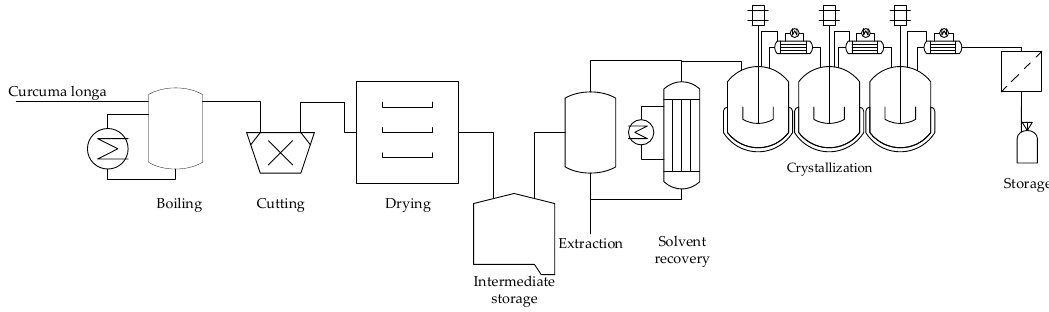
Figure 7. Small and medium scale extraction process for purification of curcumin.